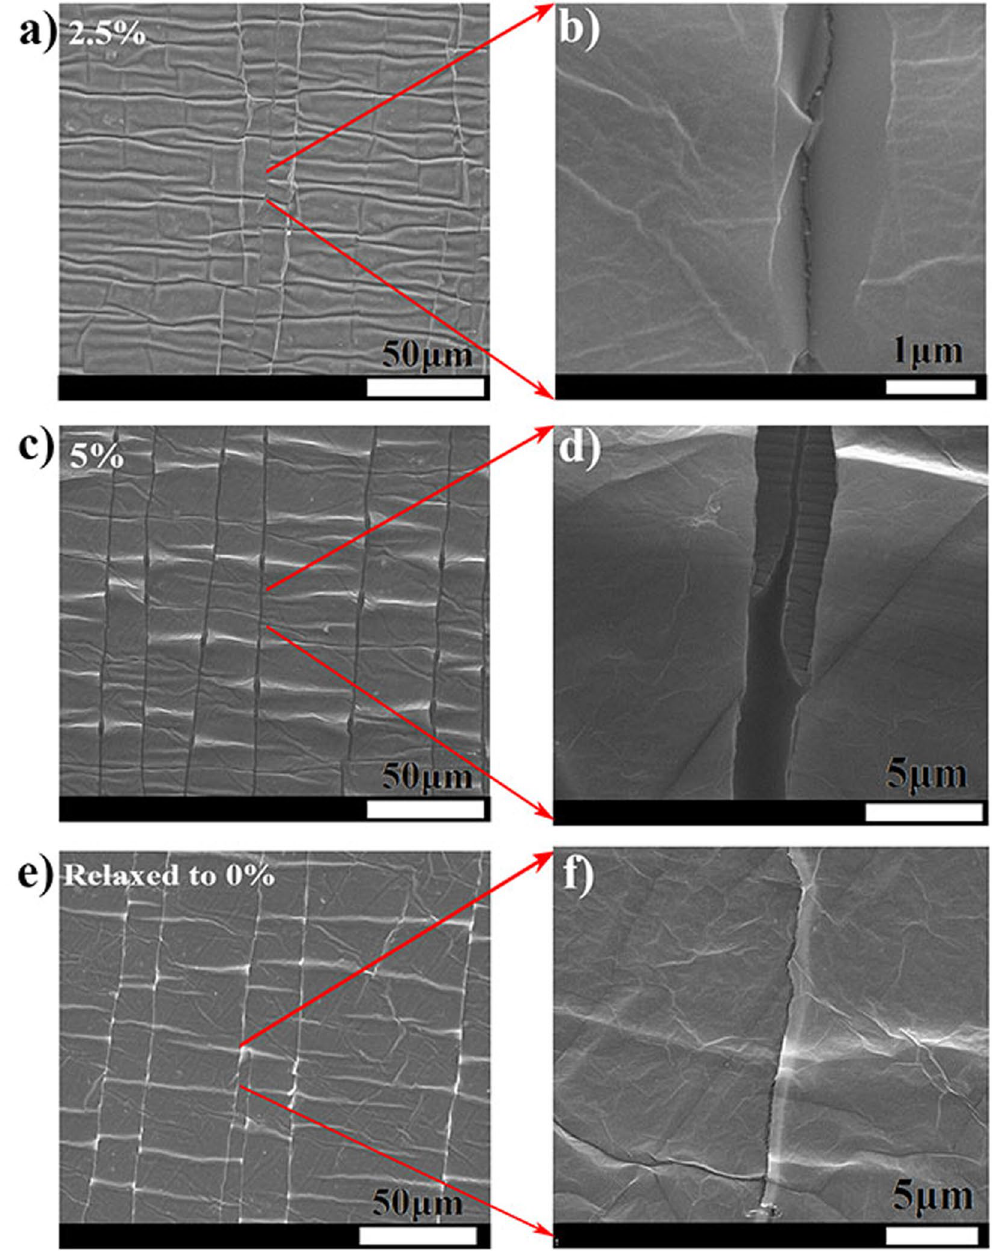
Figure 2. SEM images of 3-coat rGO-PDMS films under ( a ) 2.5% ( c ) 5% ( e ) Relaxed from 5% to 0%. ( b ), ( d ) an ( f ) are the zoomed in versions